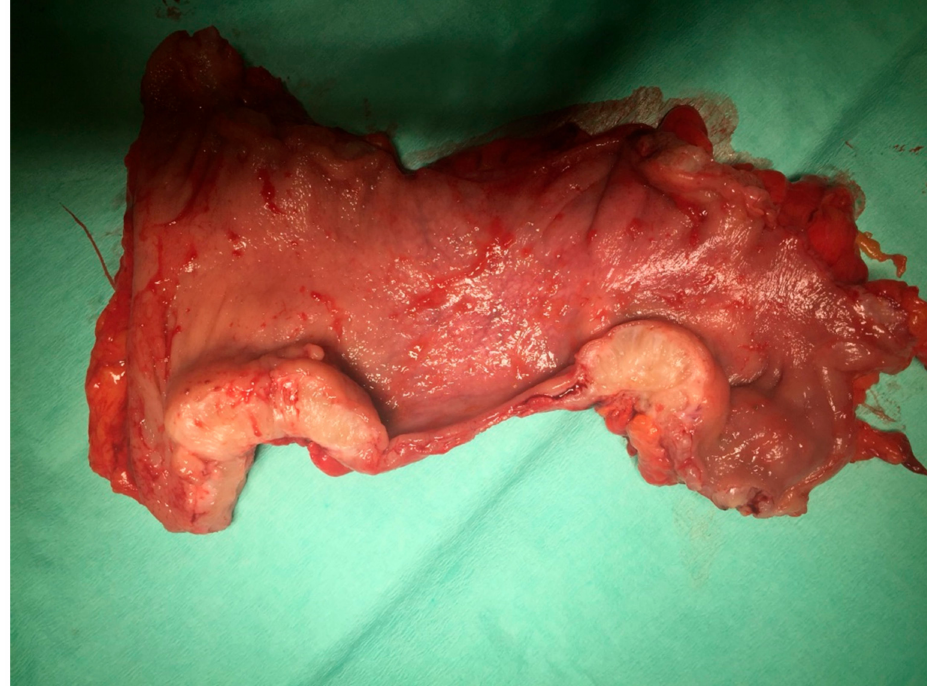
Figure 1. Intestinal endometriosis (from Department of Operative Gynaecology and